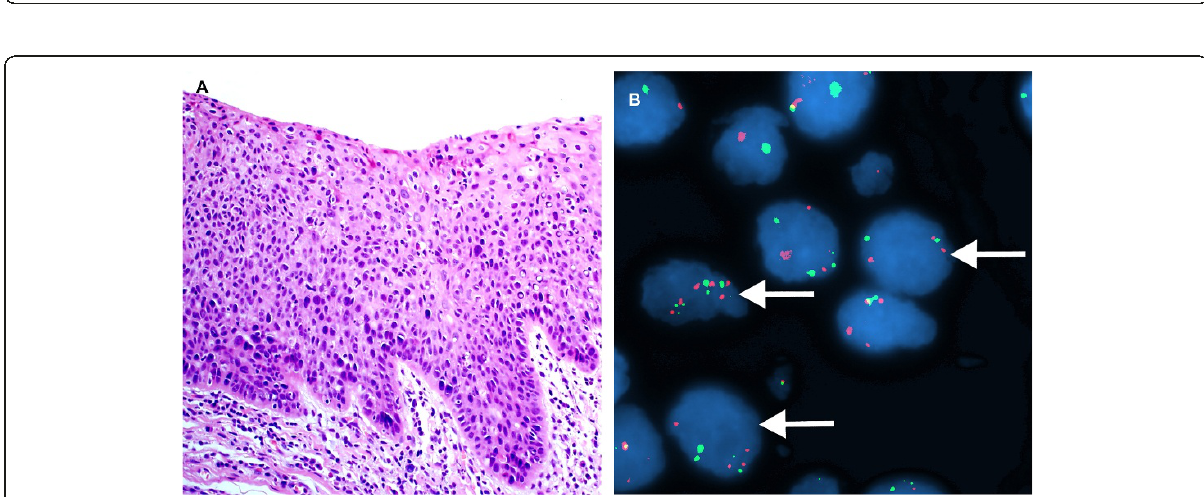
Figure 4 A case of sereve dysplasia of the larynx . A. H&E stain. (×200). B. Interphase FISH displaying a CSP3: hTERC signal pattern is 2:3, 2:5, 3:3, and etc. (×1000).